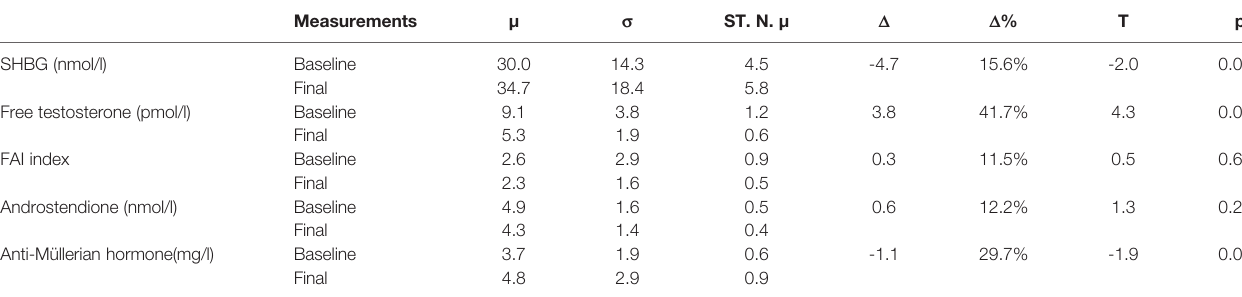
TABLE 4 | Comparison between baseline and fi nal measurements of hormone and proteins. Measurements µ s ST. N. µ D D % T SHBG (nmol/l) Baseline